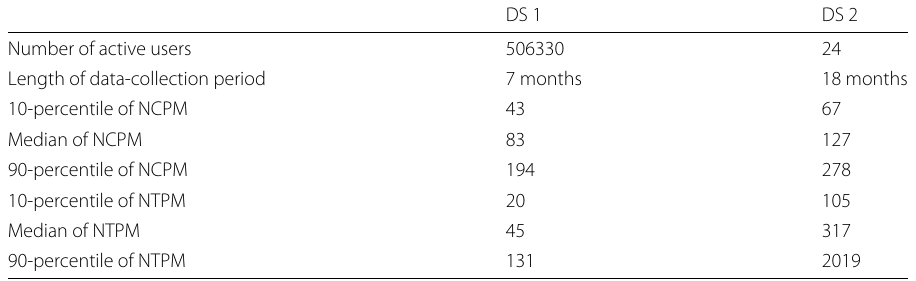
and text messages for 24 students in the UK (Roberts and Dunbar 2011; Saramäki et